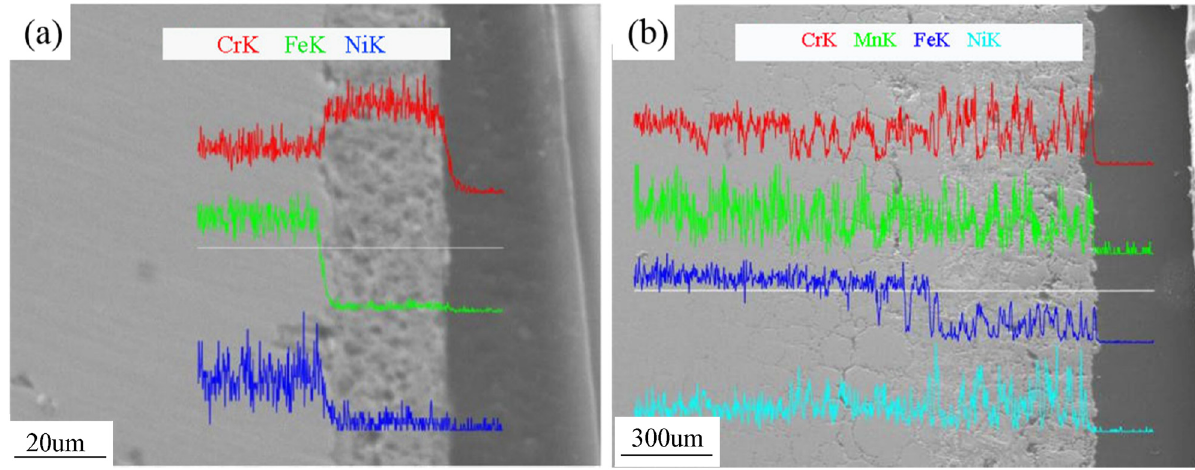
Figure 5: Cross - sectional morphologies of Inconel 625 alloy after corrosion in ternary chloride molten salt at 700°C ( a ) and 900°C ( b ) for 60 h together with element distributions along the white lines.